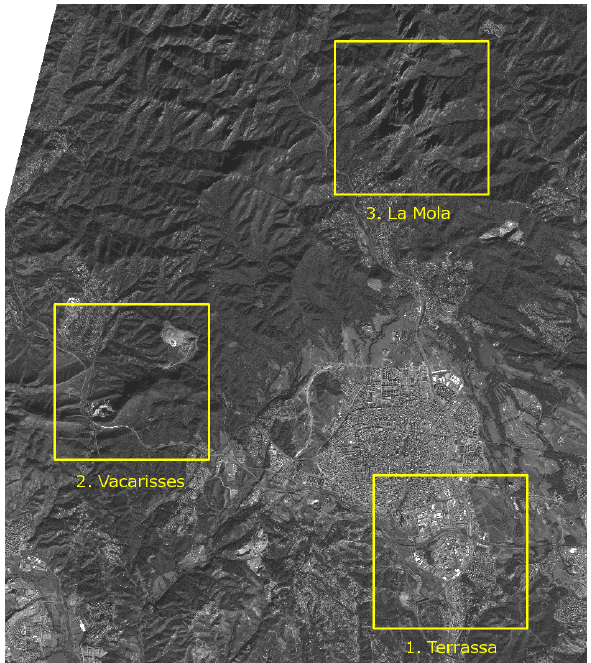
Figure 1: Cartosat-1 image showing the three test areas.